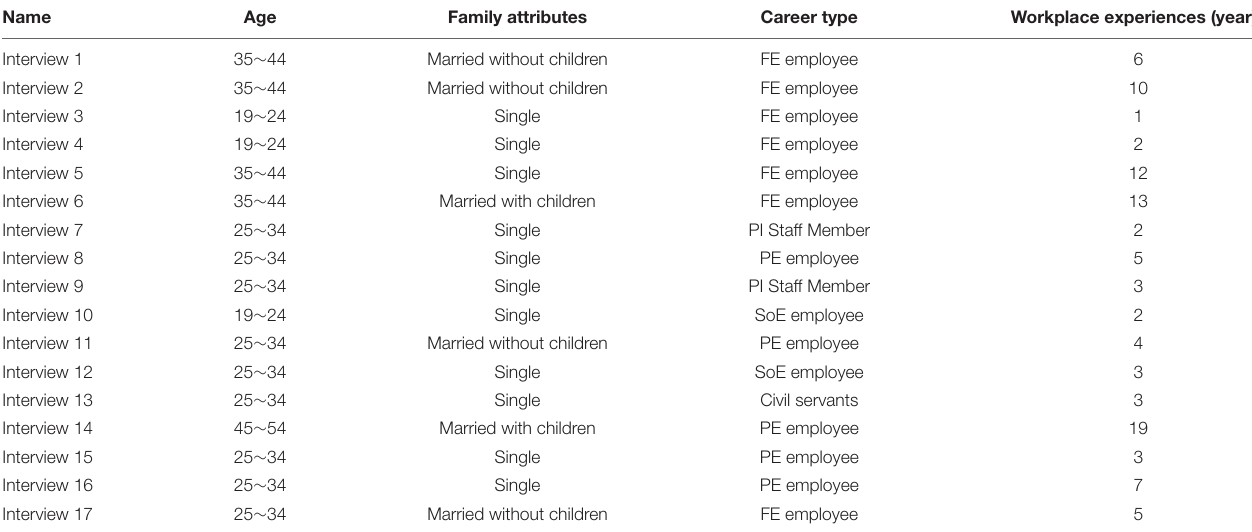
TABLE 2 | Basic information of the respondent.